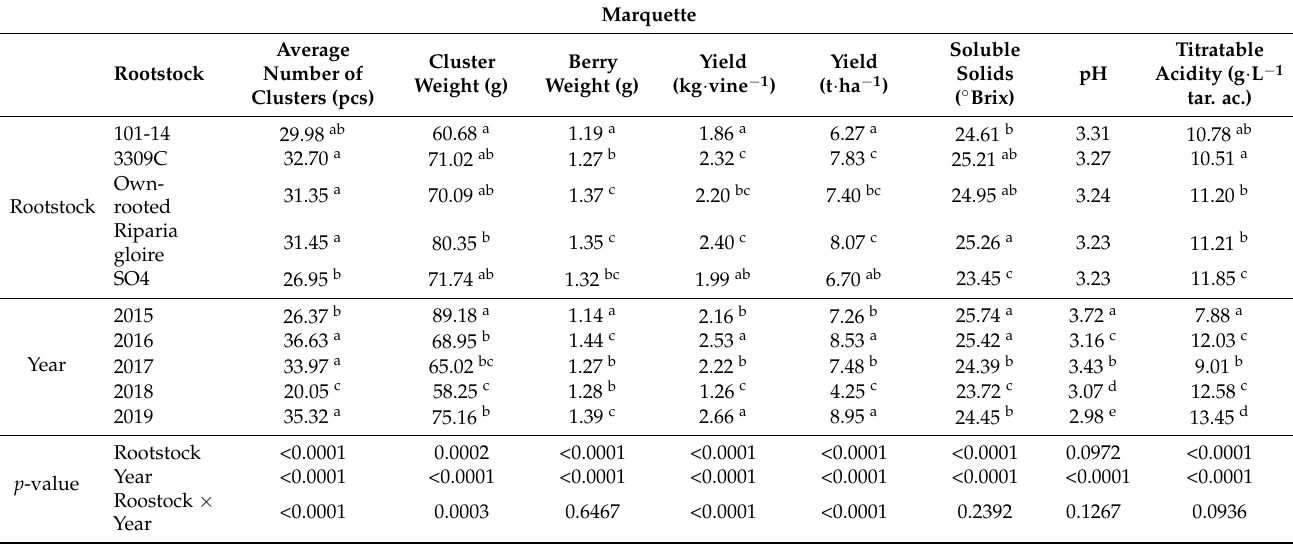
Table 9. Effect of rootstock on yield quantity and fruit composition of grapevine